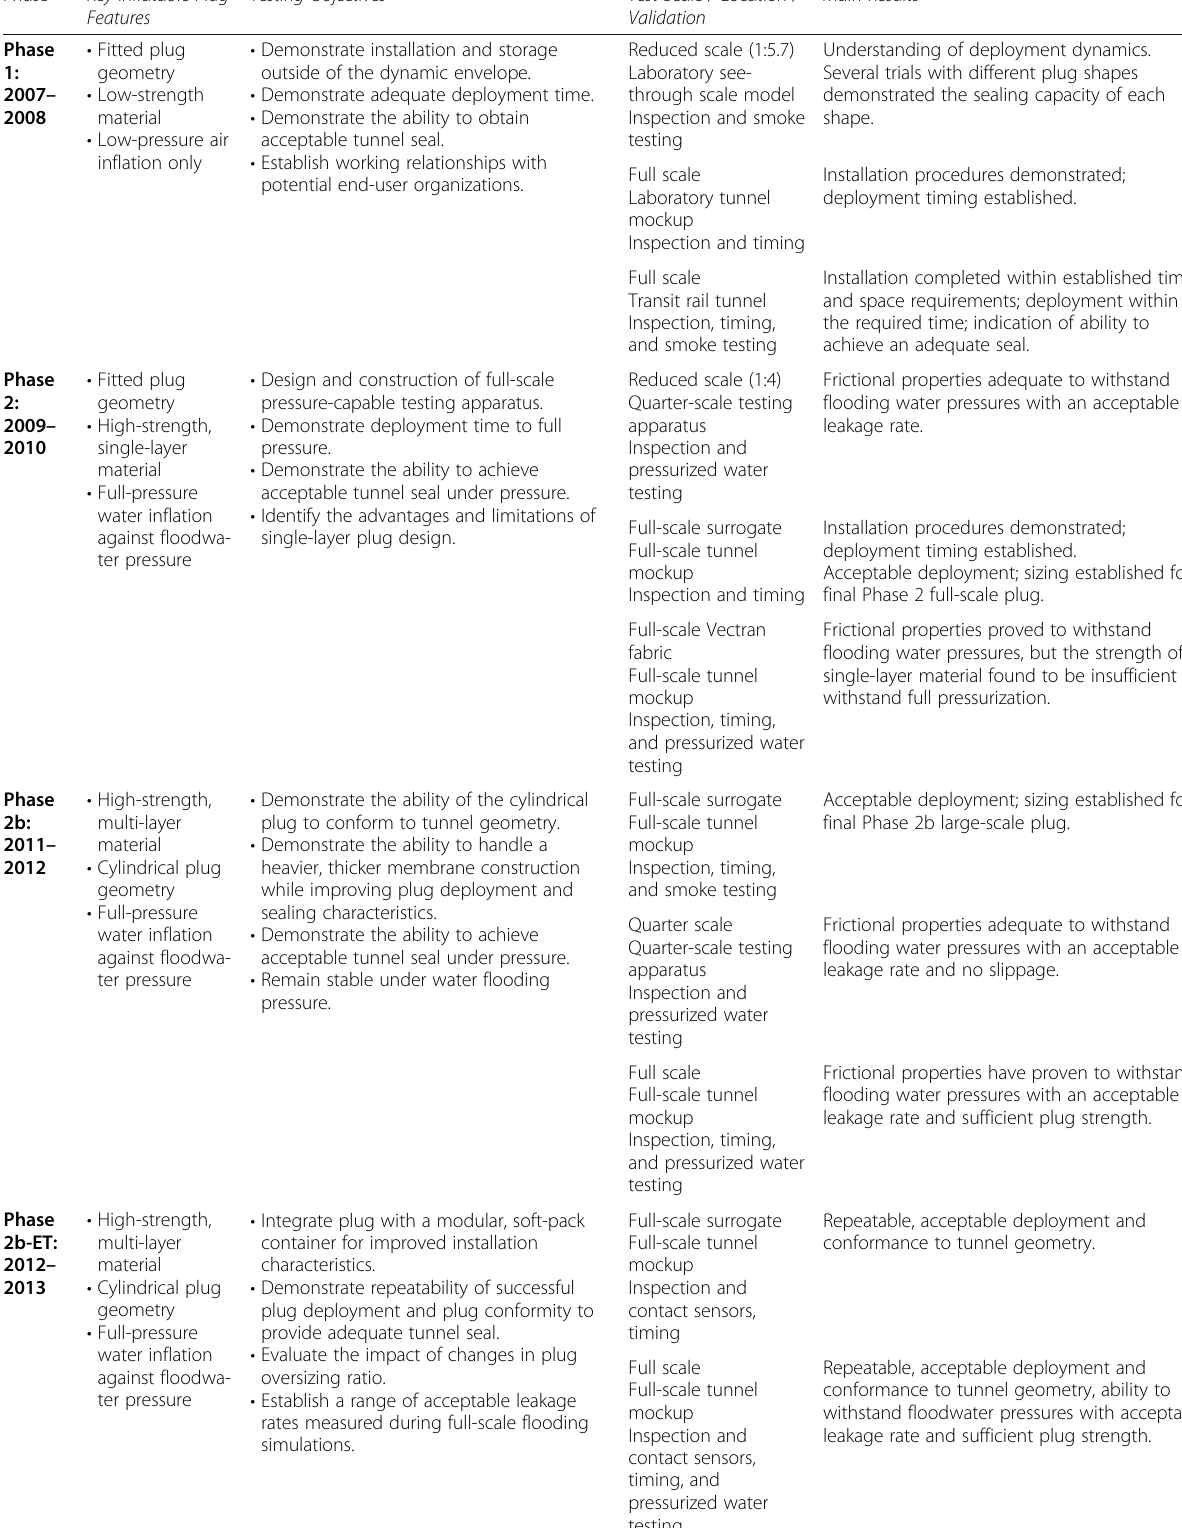
Table 2 Summary of key parameters, objectives, and main results obtained from each phase Phase Key Inflatable Plug